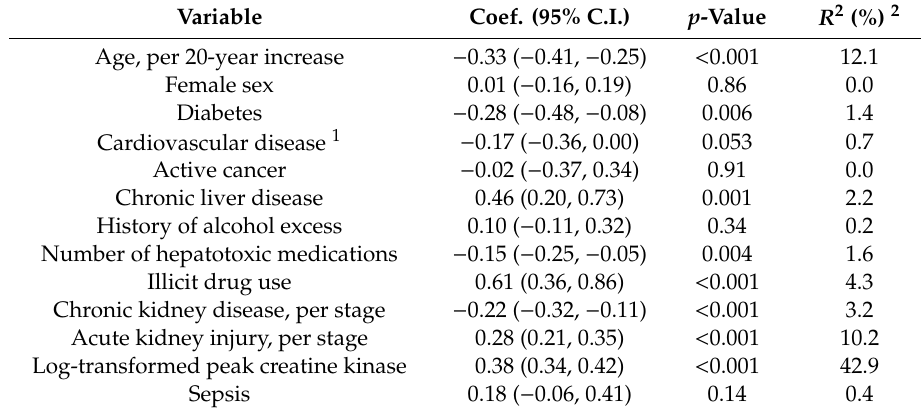
Table 4. Univariable linear regression